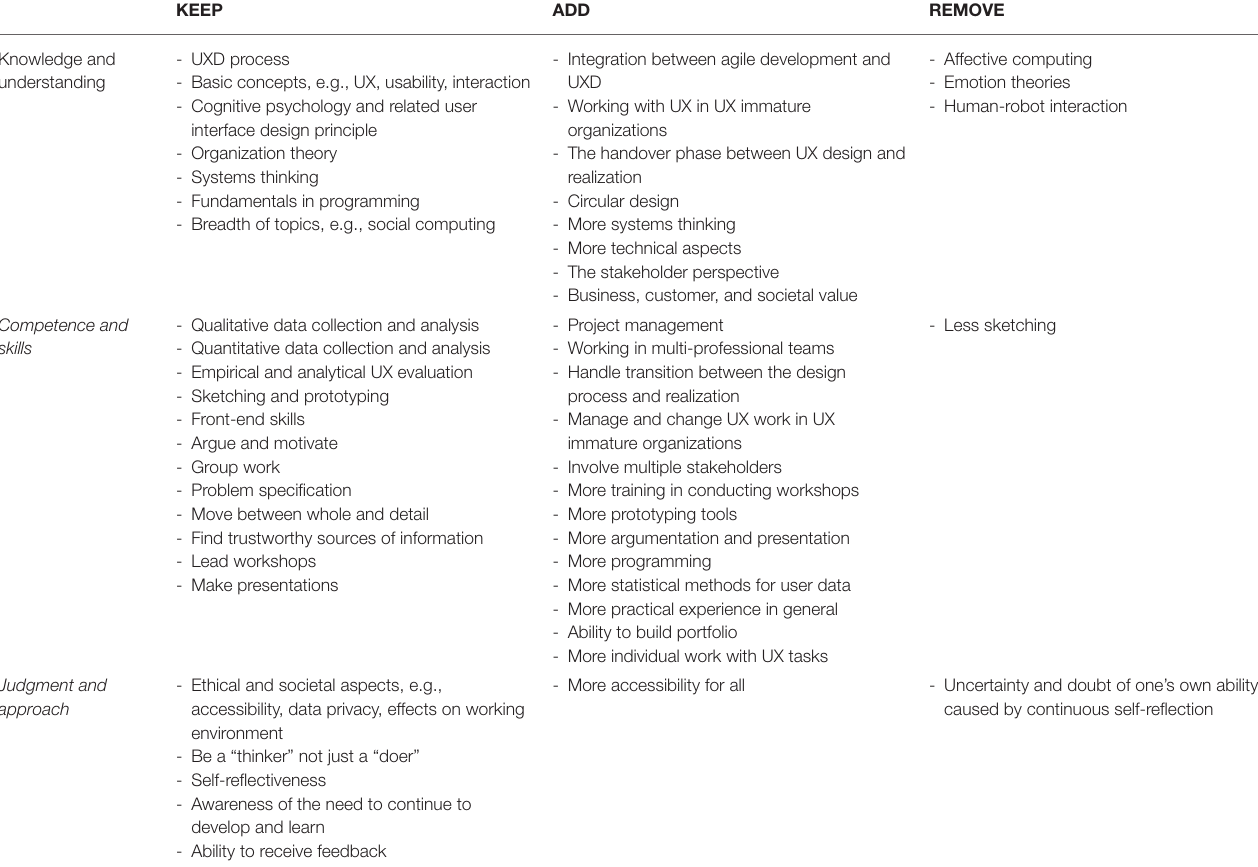
TABLE 1 | Overview of findings in the follow-up. KEEP ADD